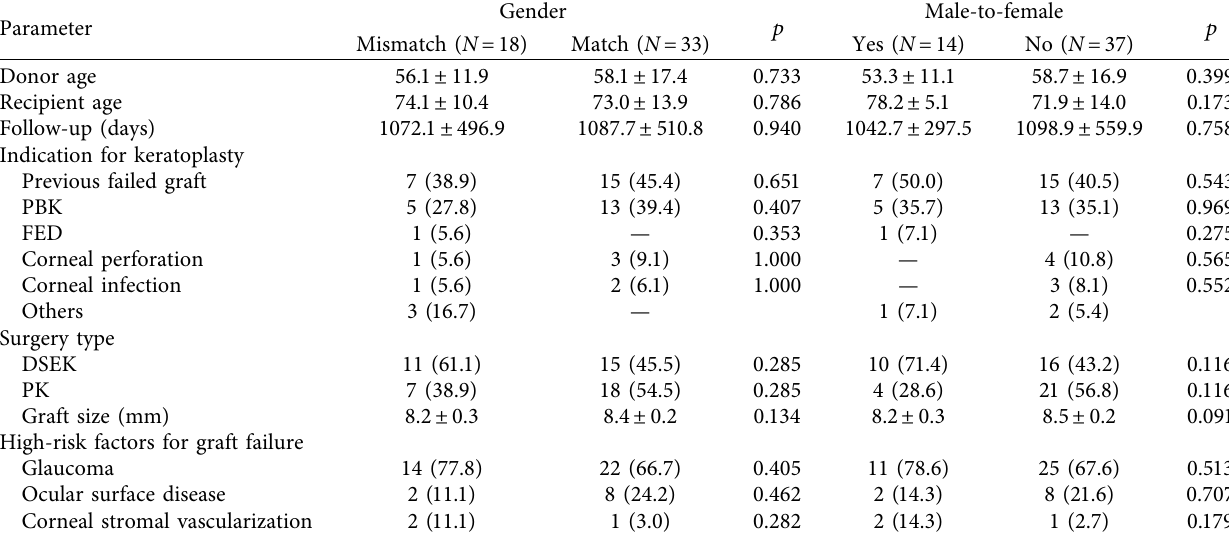
Table 1: Baseline characteristics of the 51 high-risk